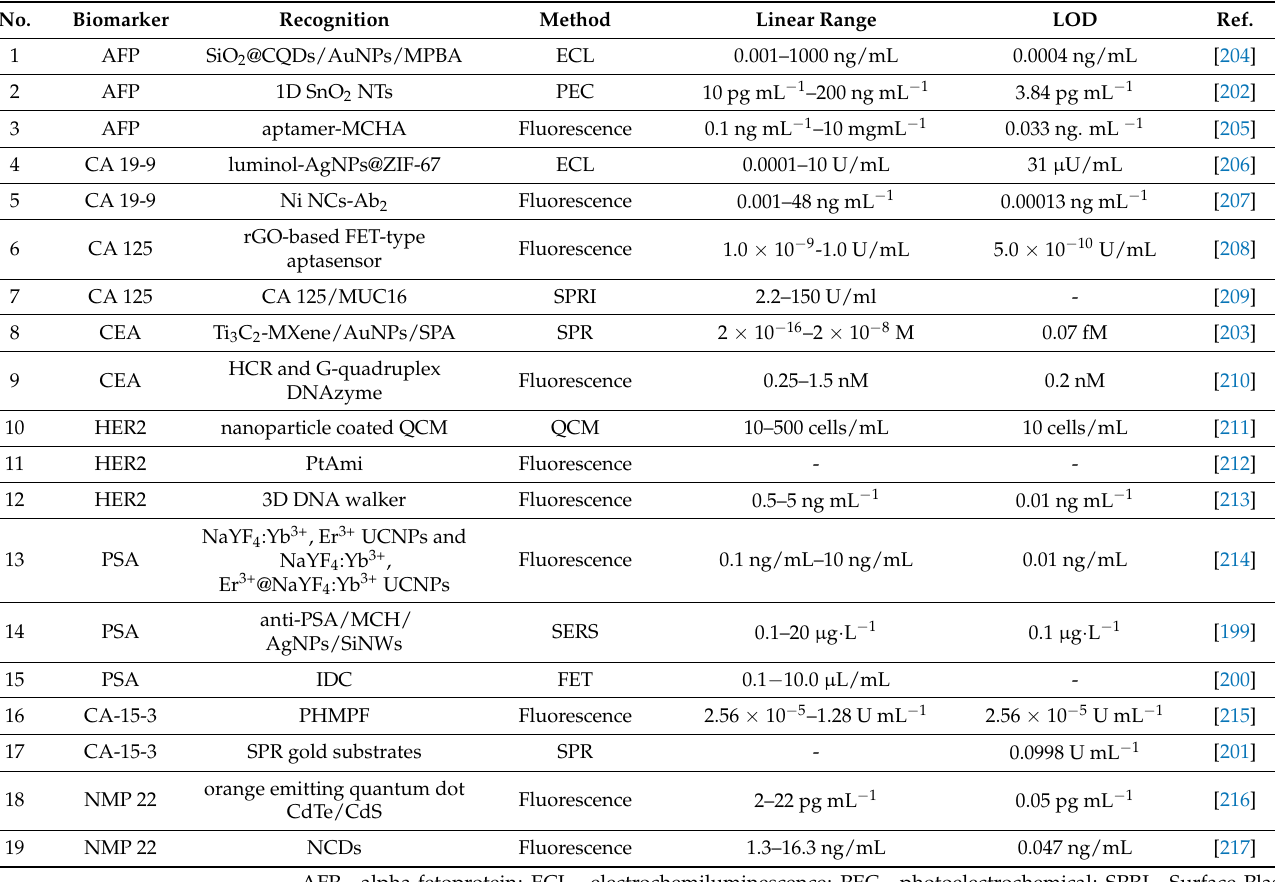
Table 2. Optical sensing methodologies for cancer biomarker